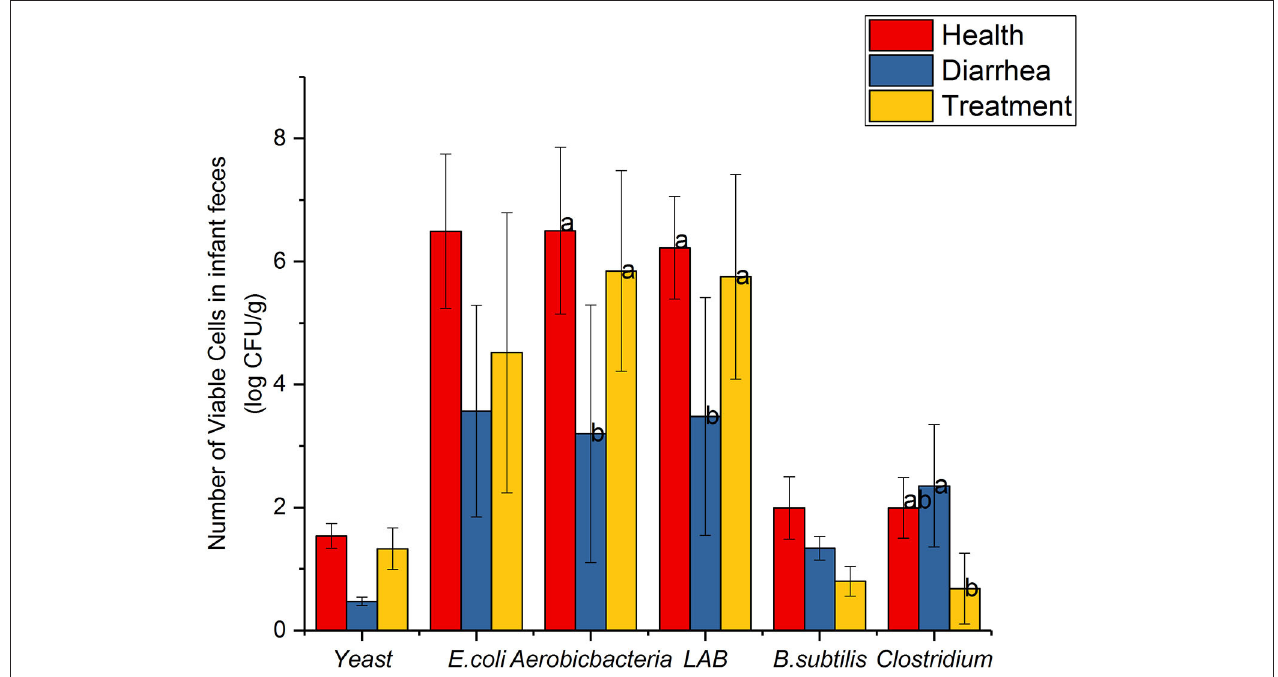
FIGURE 2 | Common viable microbes in infant feces. Different letters above the bars denote statistically significant differences among groups ( P <